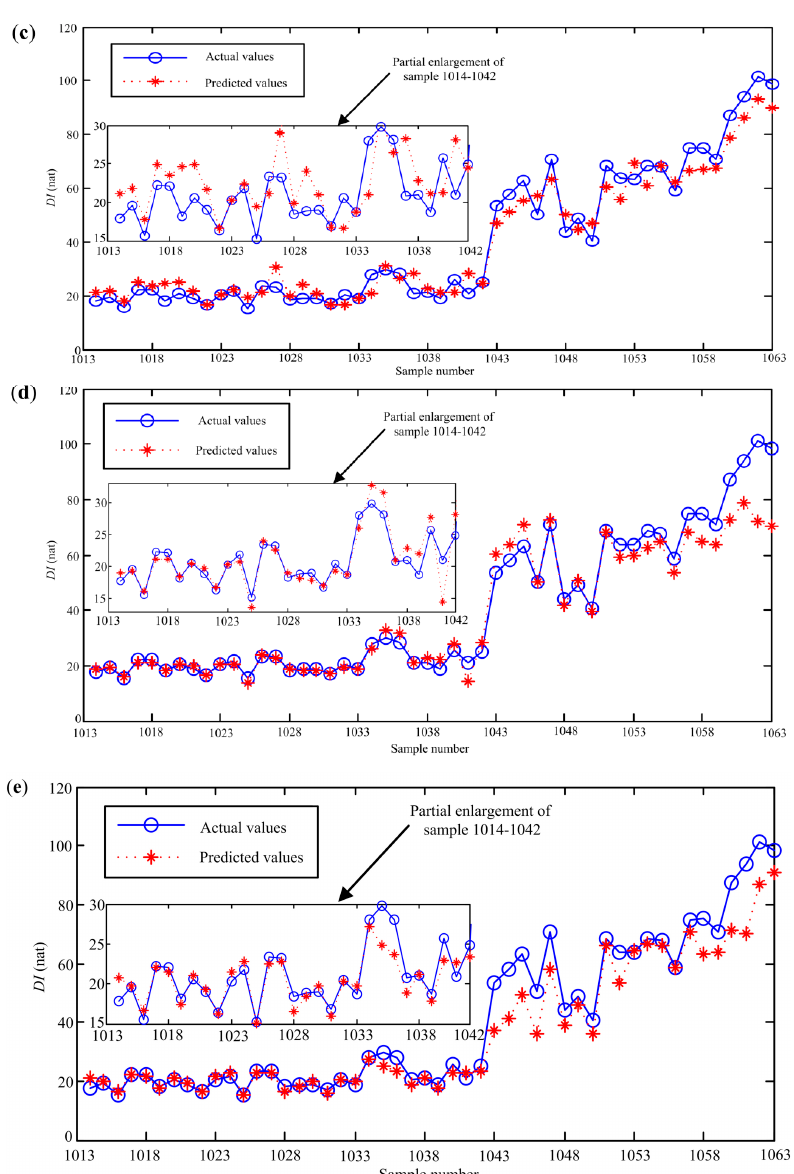
Figure 13. The actual values and predicted results based on different methods; ( a ) BP ( b )GS-SVR ( c ) GA-SVR ( d ) PSO-SVR( e ) LSTM.